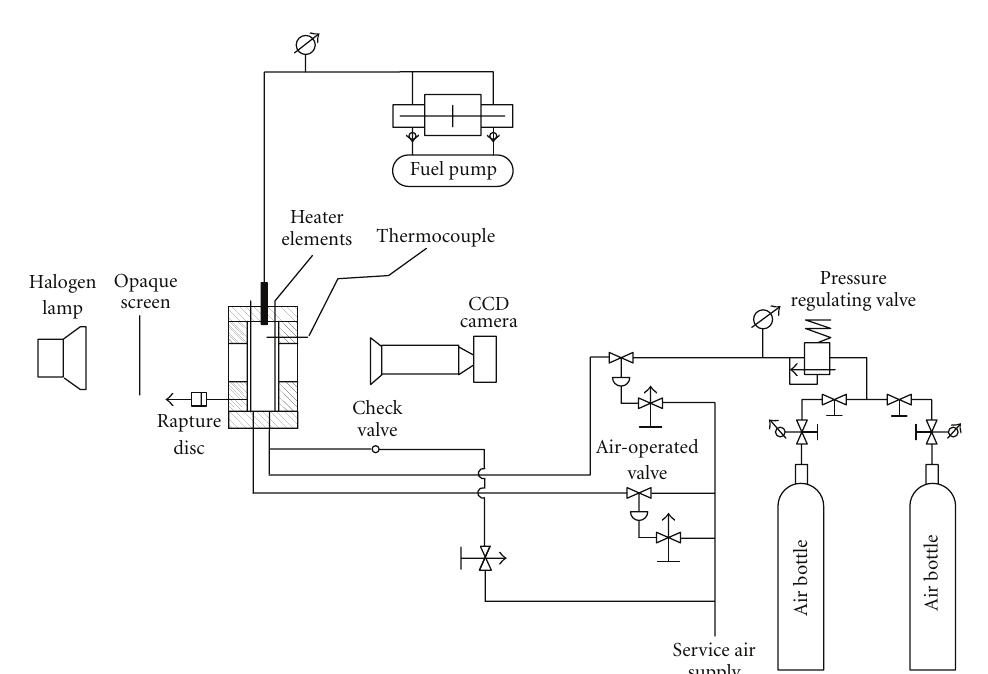
Figure 1: Schematic view of the experimental